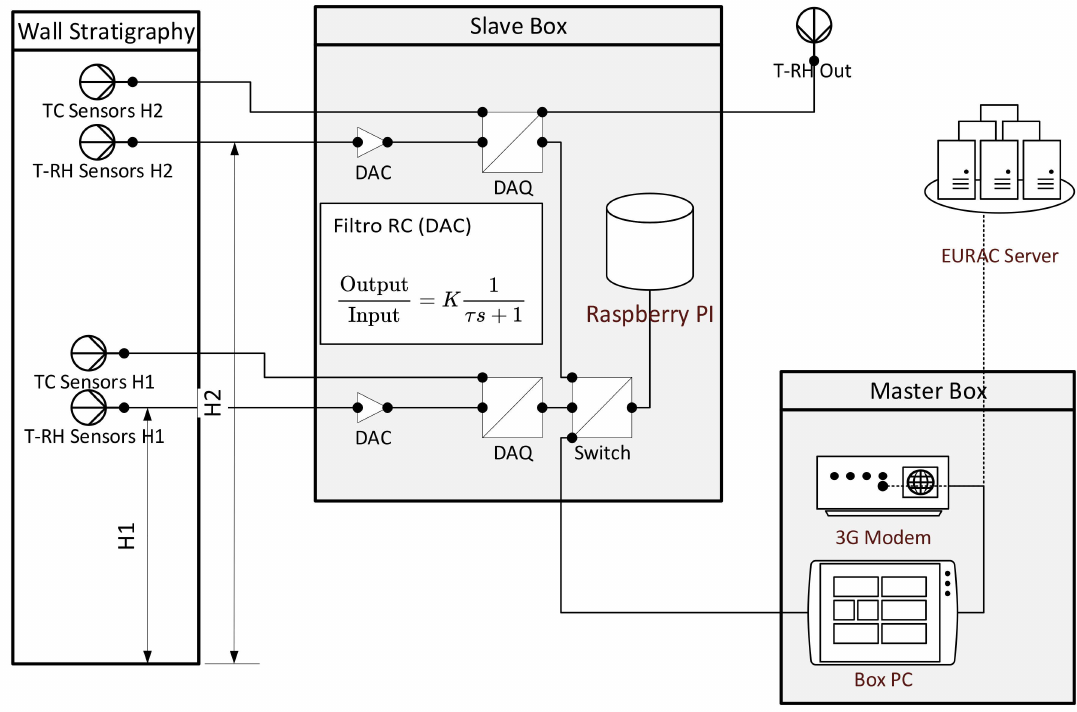
Figure 4. Logical architecture scheme (design by D.